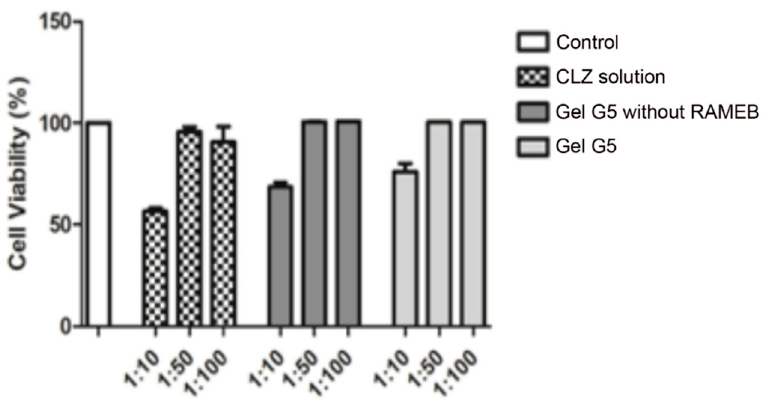
Figure 6. Caco-2 cells viability after 2 h exposure to the clonazepam (CLZ) gel formulation G5 (see Table 2 for composition), or the corresponding formulation without RAMEB, or a CLZ solution, all at different dilutions (1:10, 1:50 and 1:100).